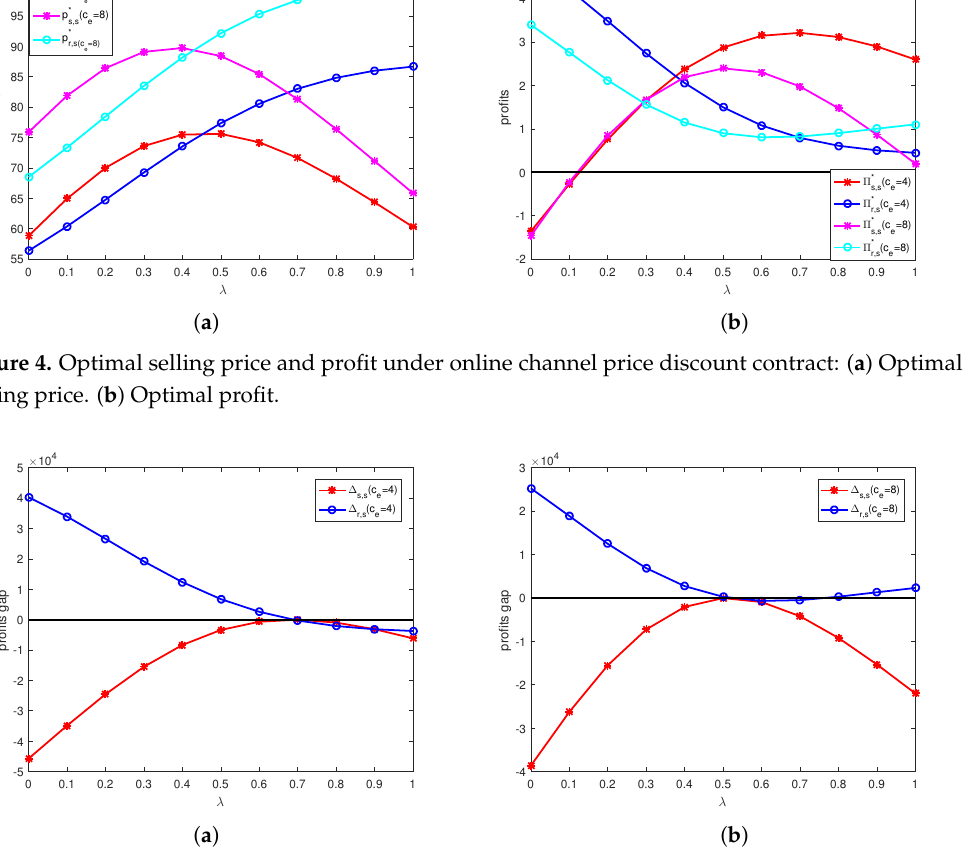
Figure 5. The profit gap before and after online channel price discount contracts under different unit price of carbon trade: ( a ) c e = 4. ( b ) c e = 8.